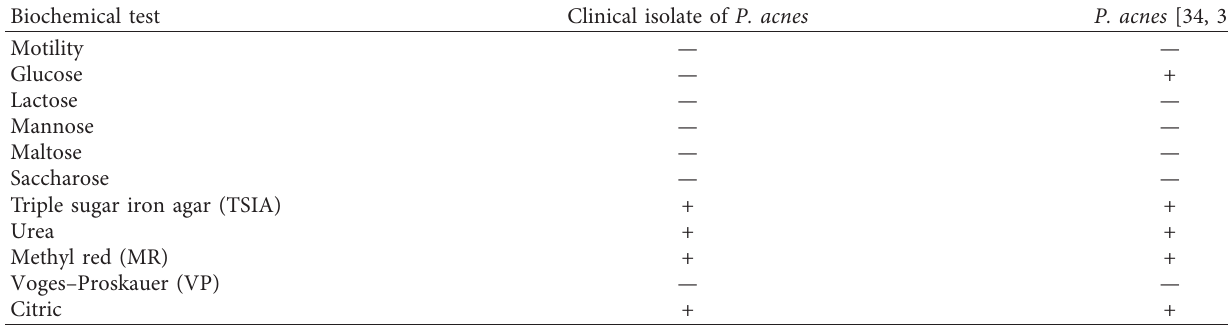
Table 4: Biochemical test results of clinical isolates of P. acnes .